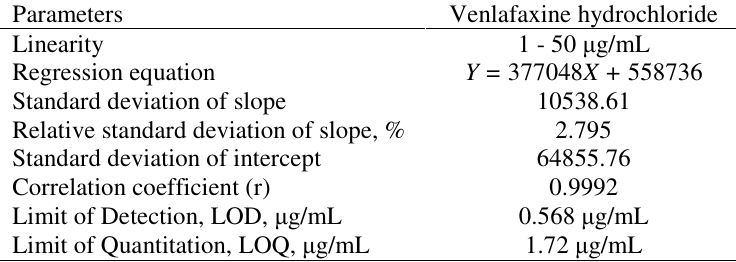
Table 6. Statistical data of calibration curves of venlafaxine